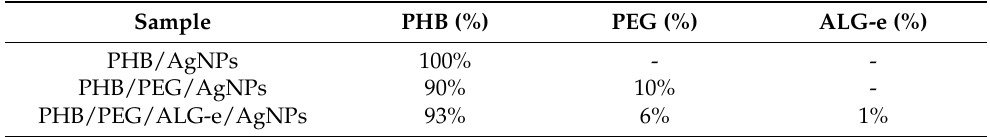
Table 1. Relationship between the amounts of the polymers used in the preparation of film-forming precursor